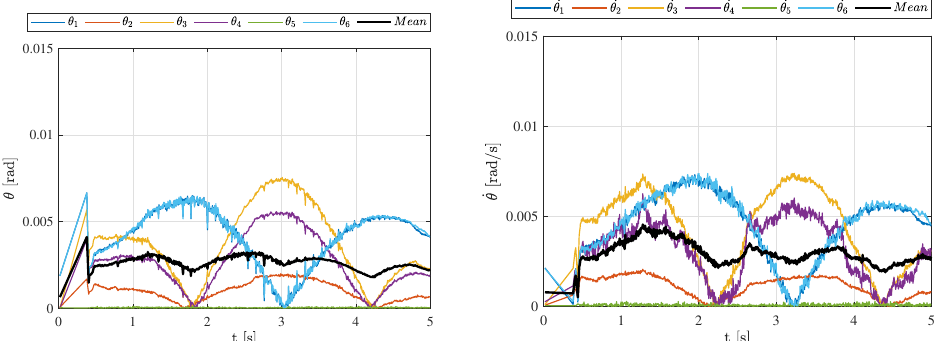
Figure 5. Test case 1, Mode I. Joint rotations ( left ) and joint speeds ( right ).